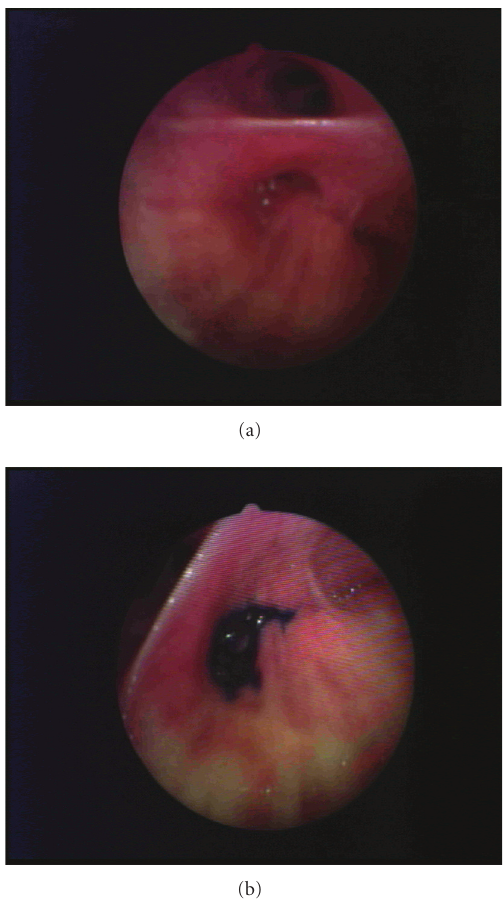
Figure 1: BPF before (a) and after (b) retrograde instillation of Methylene